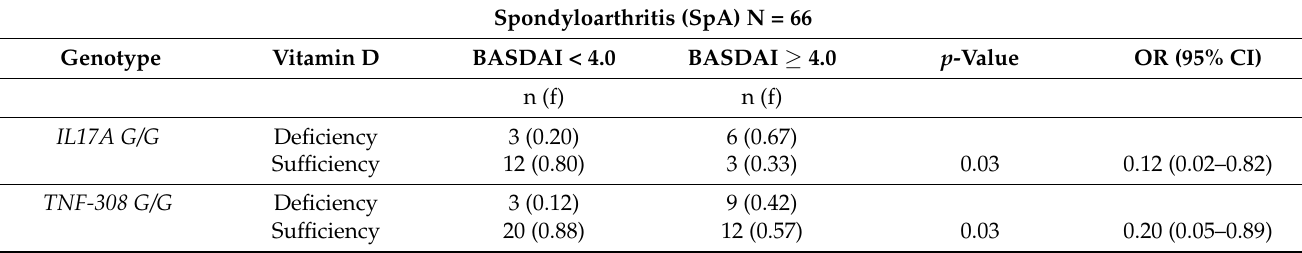
Table 4. Association of IL17 and TNF polymorphisms with SpA HLA-B*27 negative patients evaluated according to BASDAI and vitamin D